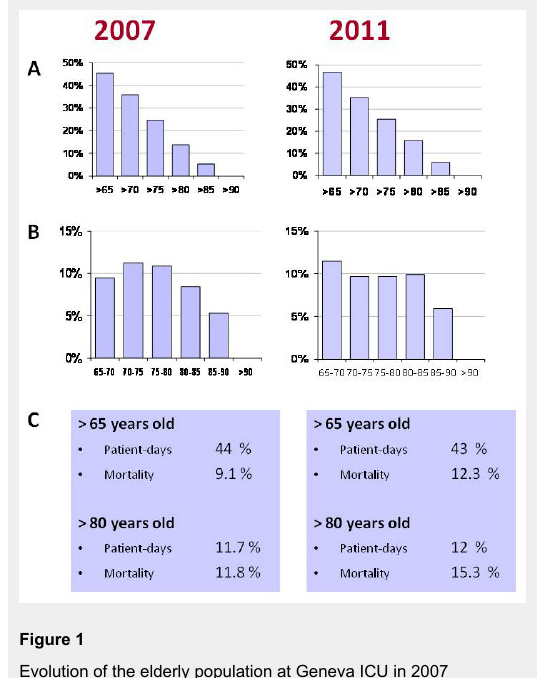
Evolution of the elderly population at Geneva ICU in 2007 compared to 2011. A Percentages of patients of more than 65, 70, 75, 80, 85 and 90 years of age. B Distribution by section of 5 years shows a trend towards more patients above 80 years in 2011. C The consumption expressed as patients-days remains stable. The mortality remains stable,